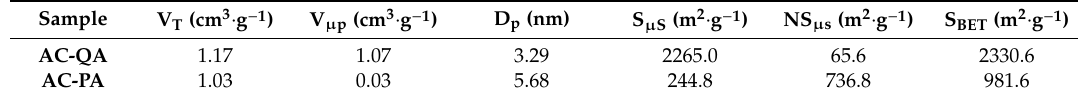
Table 1. Textural characterization of the activated